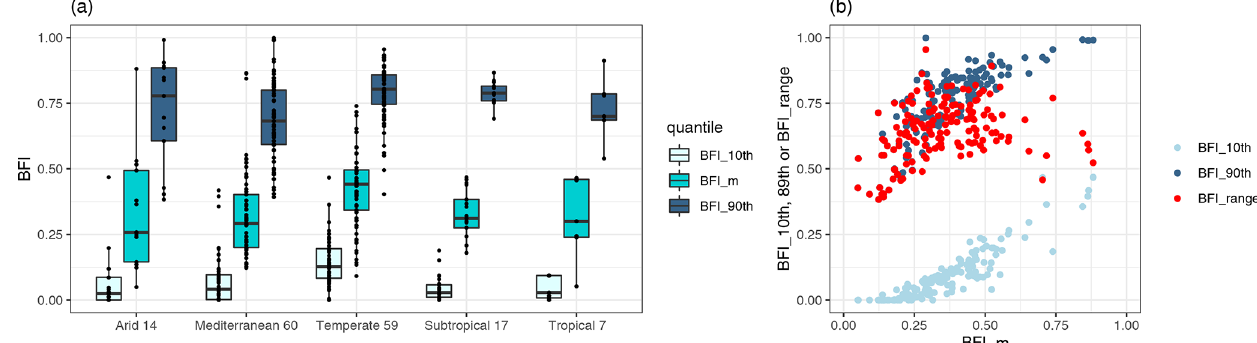
Figure 3. (a) Distribution of catchment median and the 10th and 90th percentiles of daily BFI (BFI_m, BFI_10th, BFI_90th) for each climate zone along with the number of catchments analysed ( x axis). (b) The 10th and 90th percentiles of daily BFI (BFI_10th and BFI_90th) and BFI_range (BFI_90th – BFI_10th) vs. BFI_m. Both plots include all 157 catchments across the six water quality variables studied. The corresponding plots for catchments analysed in individual water quality variables are in Figs. S4 and S5 in the